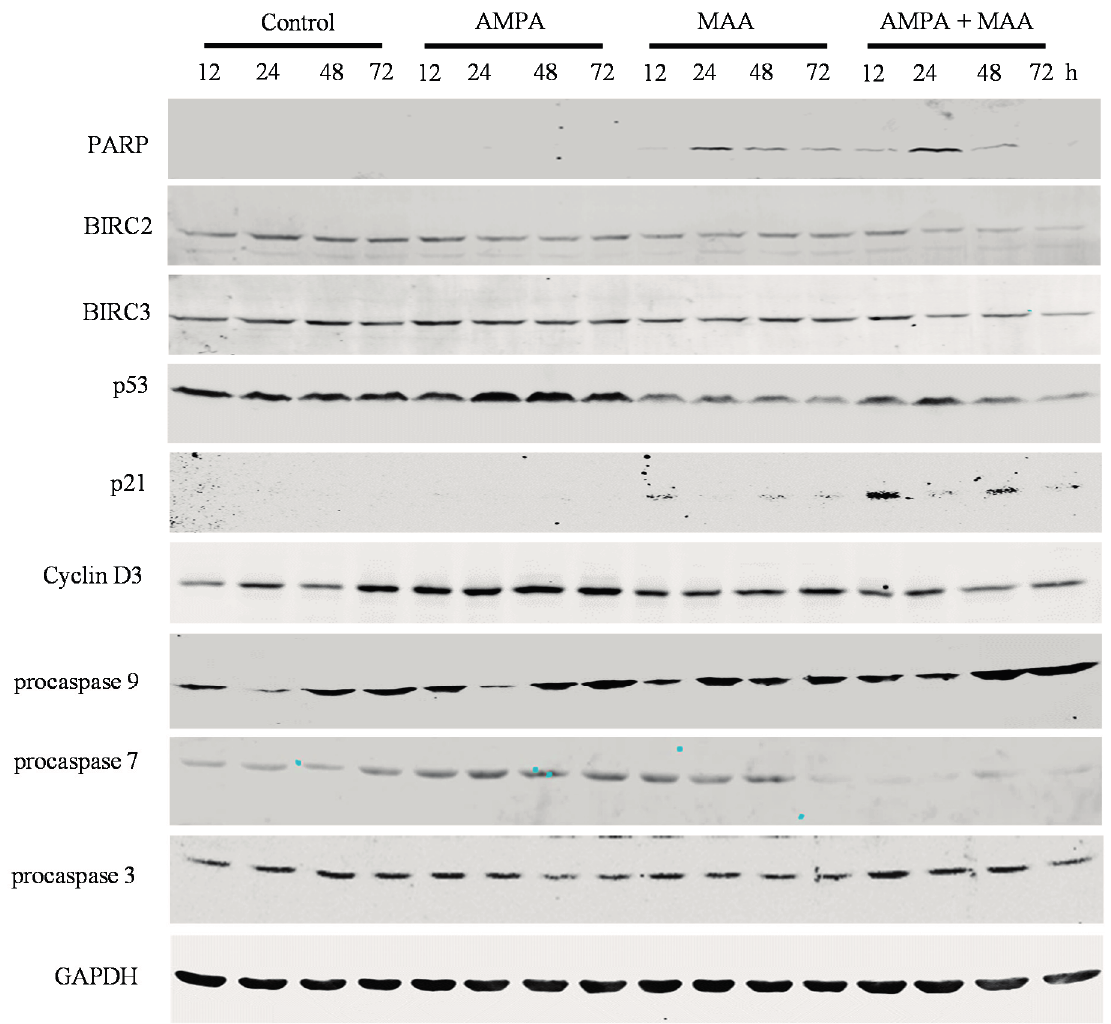
Figure 7. AMPA and MAA induce changes in the expression levels of genes involved in cell cycle arrest and apoptosis. DU-145 cells were exposed to 15 mM AMPA, 5 mM MAA or a combination of both AMPA and MAA for different time periods. The protein extracts were analyzed by Western blot to detect the indicated proteins. GAPDH was probed as the loading